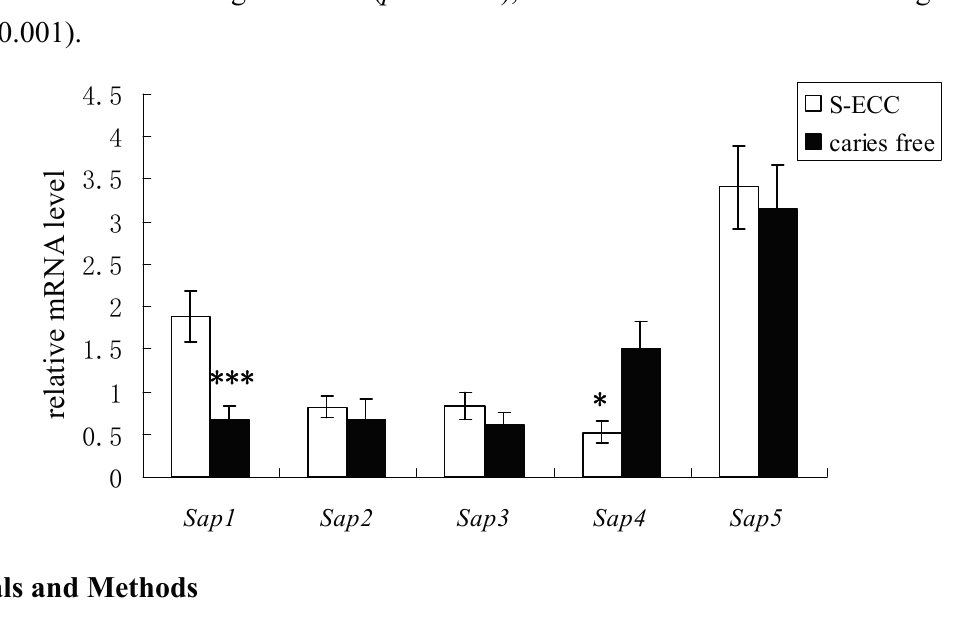
Figure 6 . The gene expression of Sap 1–5 in the S-ECC and caries-free groups. White bars and black bars represent the means (with standard deviations) of relative mRNA levels, which represent gene expression of Saps of C. albicans from S-ECC and CF